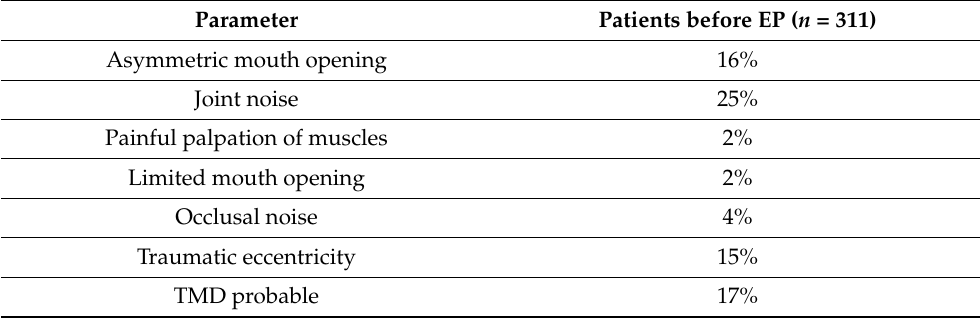
Table 5. Findings of screening for temporomandibular dysfunction (TMD) of patients before endo- prosthesis